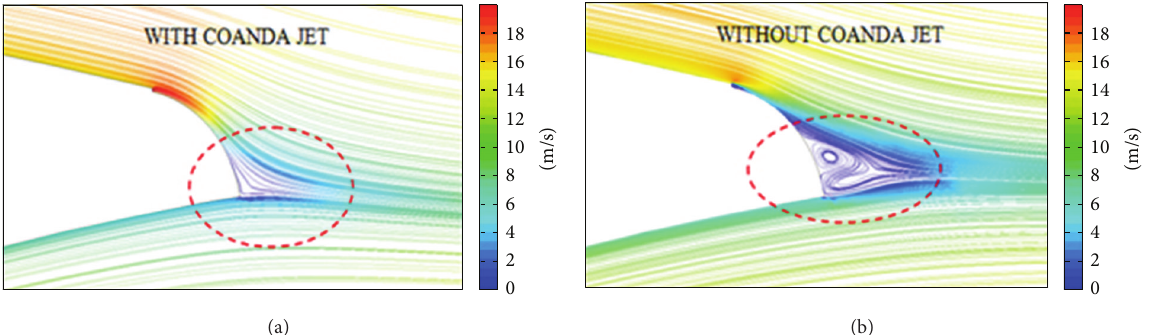
Figure 9: Velocity fields of S809 airfoil (a) with and (b) without Coand˘a-jet.